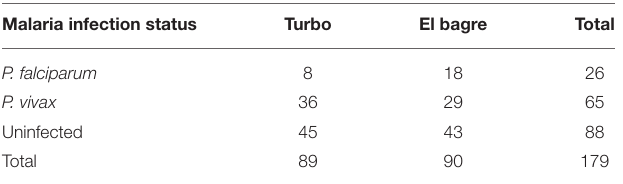
TABLE 1 | Description of the serum samples by malaria infection status and